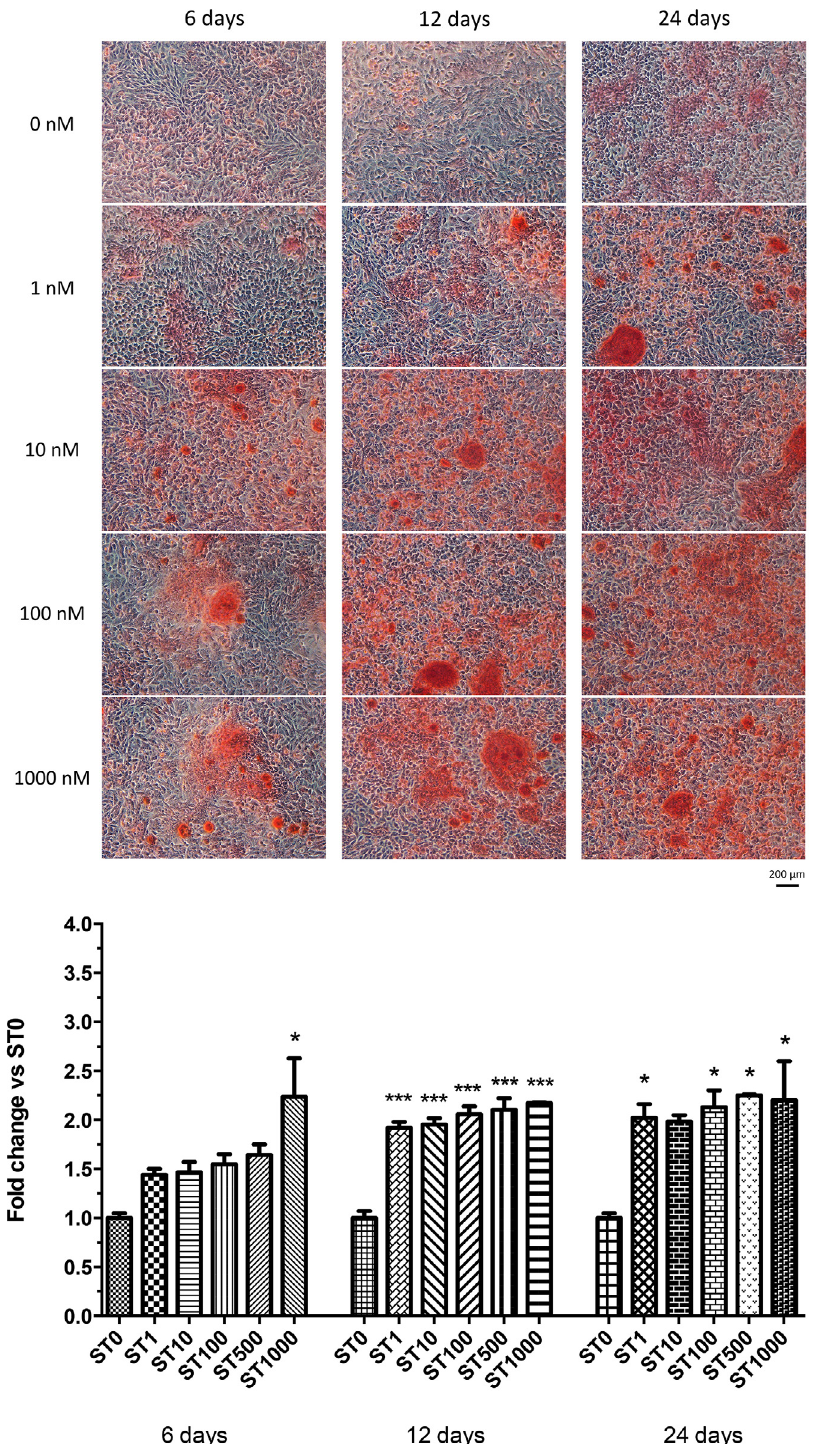
Figure 3- (a) Appearance of SaOS-cell culture treated with different stanozolol (ST) concentrations (0-1000 nM) at 6, 12 and 24 days after Alizarin Red S staining. Optical microscopy, 10X magnification; (b) Alizarin Red S staining quantification with different ST concentrations (0-1000 nM) at 6, 12 days and 24 days. Data are reported as fold change over controls and expressed as mean ± standard deviation. Asterisks indicate statistical significance (*: p<0.05 vs ST 0 nM; ** p<0.005 vs ST 0 nM; ***: p<001 vs ST 0